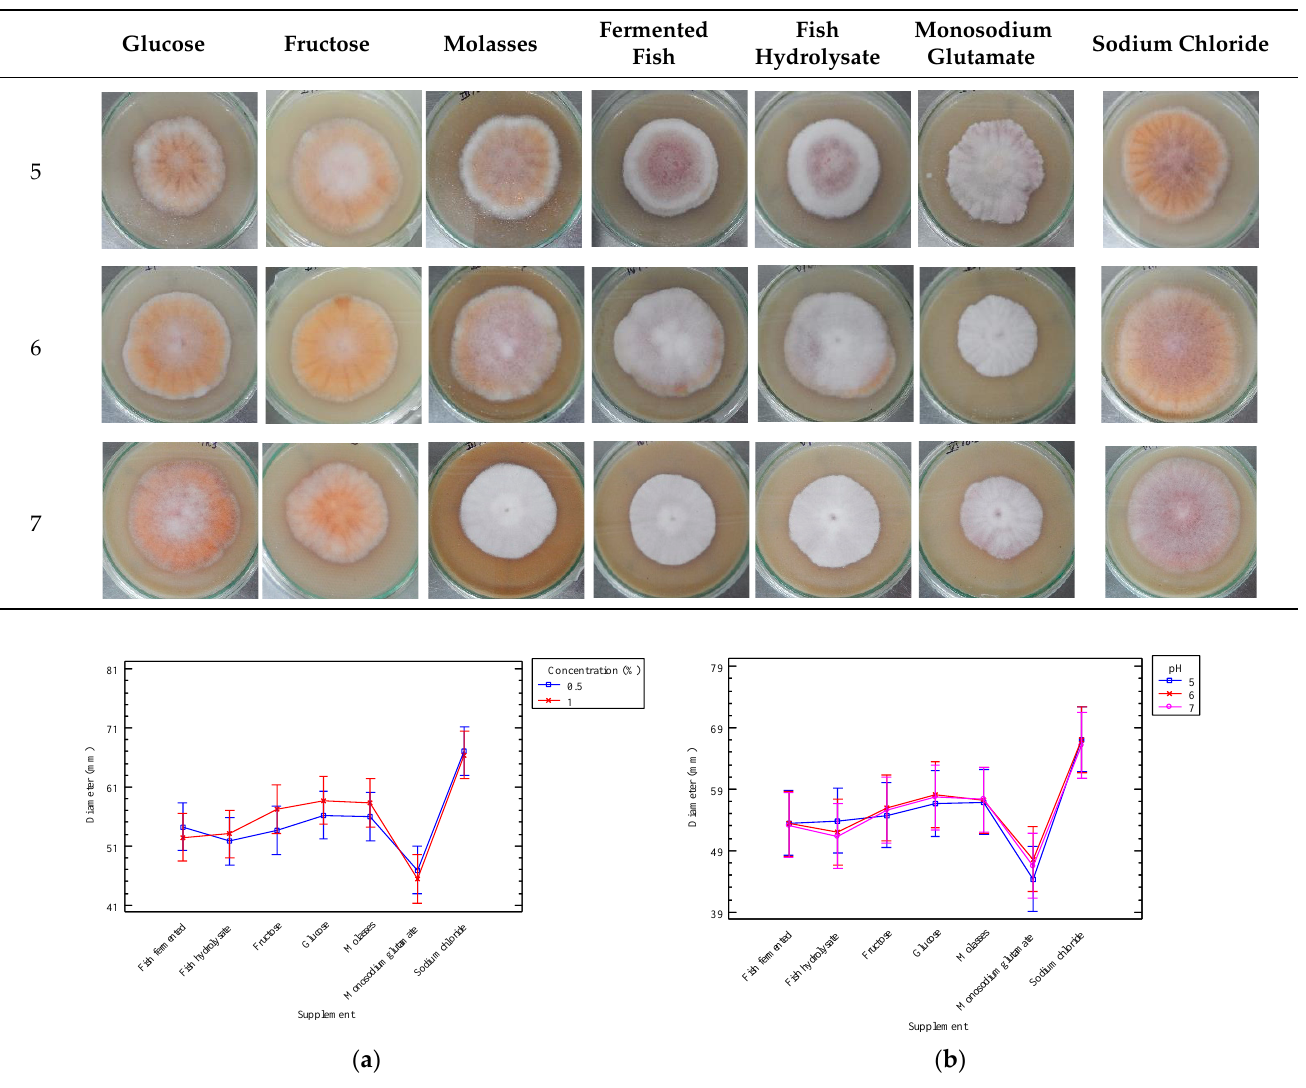
supplement. Table 3. Mycelial development of M. purpureus in culture media based on quinoa flour supplemented Table 3. Mycelial development of M. purpureus in culture media based on quinoa flour supplemented Table 3. Mycelial development of M. purpureus in culture media based on quinoa flour supplemented Table 3. Mycelial development of M. purpureus in culture media based on quinoa flour supplemented Table 3. Mycelial development of M. purpureus in culture media based on quinoa flour supplemented Table 3. Mycelial development of M. purpureus in culture media based on quinoa flour supplemented Table 3. Mycelial development of M. purpureus in culture media based on quinoa flour supplemented Table 3. Mycelial development of M. purpureus in culture media based on quinoa flour supplemented Table 3. Mycelial development of M. purpureus in culture media based on quinoa flour supplemented Table 3. Mycelial development of M. purpureus in culture media based on quinoa flour supplemented Table 3. Mycelial development of M. purpureus in culture media based on quinoa flour supplemented Table 3. Mycelial development of M. purpureus in culture media based on quinoa flour supplemented Table 3. Mycelial development of M. purpureus in culture media based on quinoa flour supplemented Table 3. Mycelial development of M. purpureus in culture media based on quinoa flour supplemented Table 3. Mycelial development of M. purpureus in culture media based on quinoa flour supplemented Table 3. Mycelial development of M. purpureus in culture media based on quinoa flour supplemented Table 3. Mycelial development of M. purpureus in culture media based on quinoa flour supplemented Table 3. Mycelial development of M. purpureus in culture media based on quinoa flour supplemented Table 3. Mycelial development of M. purpureus in culture media based on quinoa flour supplemented Table 3. Mycelial development of M. purpureus in culture media based on quinoa flour supplemented Table 3. Mycelial development of M. purpureus in culture media based on quinoa flour supplemented Table 3. Mycelial development of M. purpureus in culture media based on quinoa flour supplemented Table 3. Mycelial development of M. purpureus in culture media based on quinoa flour supplemented with different sources of carbon, nitrogen and salts at 0.5% ( w/v ), at 3 pH levels (5, 6 and 7) after 10th days with different sources of carbon, nitrogen and salts at 0.5% ( w/v ), at 3 pH levels (5, 6 and 7) after 10th days with different sources of carbon, nitrogen and salts at 0.5% ( w/v ), at 3 pH levels (5, 6 and 7) after 10th days with different sources of carbon, nitrogen and salts at 0.5% ( w/v ), at 3 pH levels (5, 6 and 7) after 10th days with different sources of carbon, nitrogen and salts at 0.5% ( w/v ), at 3 pH levels (5, 6 and 7) after 10th days with different sources of carbon, nitrogen and salts at 0.5% ( w/v ), at 3 pH levels (5, 6 and 7) after 10th days with different sources of carbon, nitrogen and salts at 0.5% ( w/v ), at 3 pH levels (5, 6 and 7) after 10th days with different sources of carbon, nitrogen and salts at 0.5% ( w/v ), at 3 pH levels (5, 6 and 7) after 10th with different sources of carbon, nitrogen and salts at 0.5% ( w/v ), at 3 pH levels (5, 6 and 7) after 10th days with different sources of carbon, nitrogen and salts at 0.5% ( w/v ), at 3 pH levels (5, 6 and 7) after 10th days with different sources of carbon, nitrogen and salts at 0.5% ( w/v ), at 3 pH levels (5, 6 and 7) after 10th days with different sources of carbon, nitrogen and salts at 0.5% ( w/v ), at 3 pH levels (5, 6 and 7) after 10th days with different sources of carbon, nitrogen and salts at 0.5% ( w/v ), at 3 pH levels (5, 6 and 7) after 10th days with different sources of carbon, nitrogen and salts at 0.5% ( w/v ), at 3 pH levels (5, 6 and 7) after 10th days with different sources of carbon, nitrogen and salts at 0.5% ( w/v ), at 3 pH levels (5, 6 and 7) after 10th days with different sources of carbon, nitrogen and salts at 0.5% ( w/v ), at 3 pH levels (5, 6 and 7) after 10th days with different sources of carbon, nitrogen and salts at 0.5% ( w/v ), at 3 pH levels (5, 6 and 7) after 10th days with different sources of carbon, nitrogen and salts at 0.5% ( w/v ), at 3 pH levels (5, 6 and 7) after 10th days with different sources of carbon, nitrogen and salts at 0.5% ( w/v ), at 3 pH levels (5, 6 and 7) after 10th days with different sources of carbon, nitrogen and salts at 0.5% ( w/v ), at 3 pH levels (5, 6 and 7) after 10th days with different sources of carbon, nitrogen and salts at 0.5% ( w/v ), at 3 pH levels (5, 6 and 7) after 10th days with different sources of carbon, nitrogen and salts at 0.5% ( w/v ), at 3 pH levels (5, 6 and 7) after 10th days with different sources of carbon, nitrogen and salts at 0.5% ( w/v ), at 3 pH levels (5, 6 and 7) after 10th days of incubation. of incubation. of incubation. of incubation. of incubation. of incubation. of incubation. days of incubation. of incubation. of incubation. of incubation. of incubation. of incubation. of incubation. of incubation. of incubation. of incubation. of incubation. of incubation. of incubation. of incubation. of incubation. of incubation.